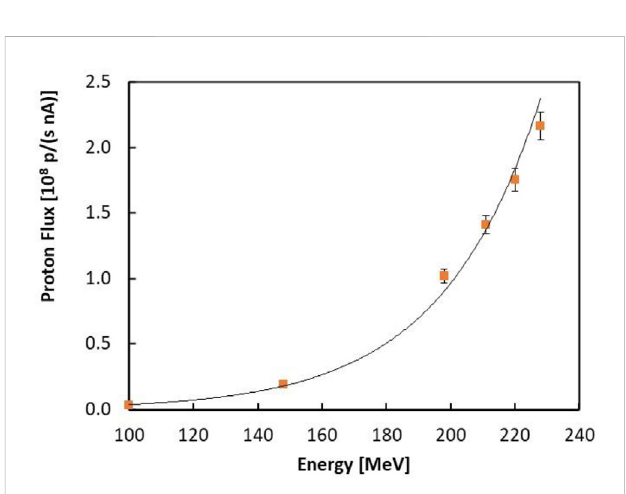
FIGURE 2 Proton fl uxincidentonthedetectorareaperunitextractioncurrent (1 nA)plottedasafunctionoftheprotonbeamenergy.Exponentialbest- fi ts is shown only for guide-line